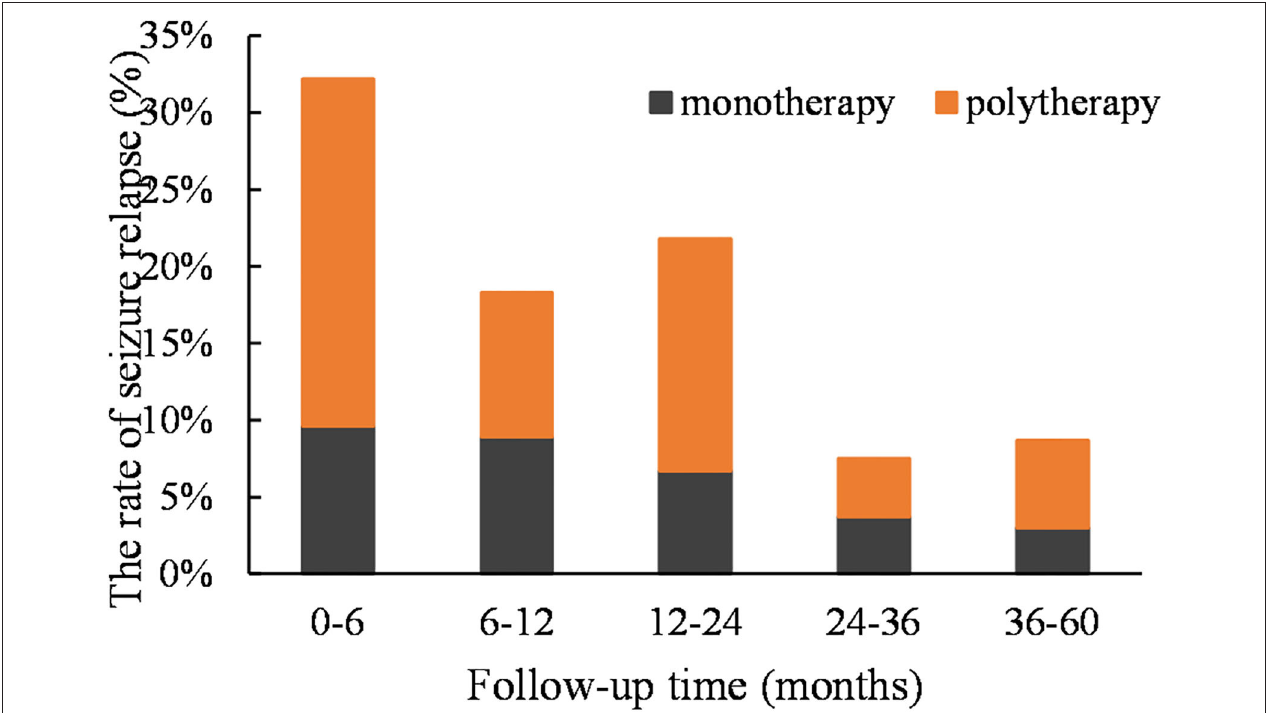
FIGURE 2 | The staged recurrence rates of two groups of patients at 0–6, 6–12, 12–24, 24–36, and 36–60 months. The peak occurred in the first 12 months (mainly in the first 6 months) in both groups.